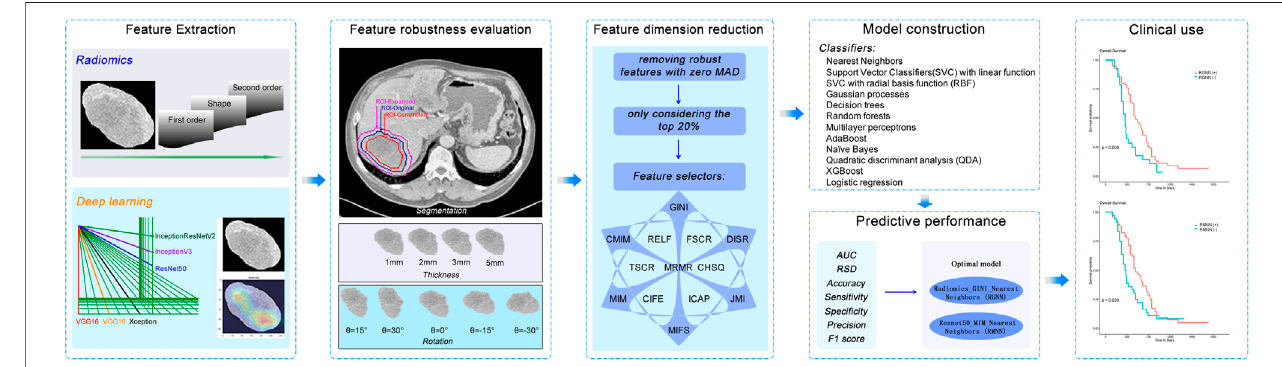
FIGURE 1| Work fl ow ofmajor steps in the current work. Tumors are segmented manuallyand pre-processed. Features are extracted with handcrafted radiomics and six popularly used pre-trained deep learning CNNs, respectively. ICC meters the robustness of features for each perturbation type (segmentation, thickness, and rotation). Robust features are then used to construct models for predicting short-term disease control of tumors by combining each of 13 feature selectors and 12 machine learning classi fi ers. The best-performing model is evaluated for predicting overall survival.